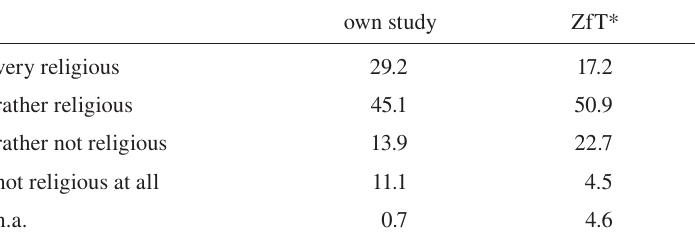
Table 2 : Oversample of very religious